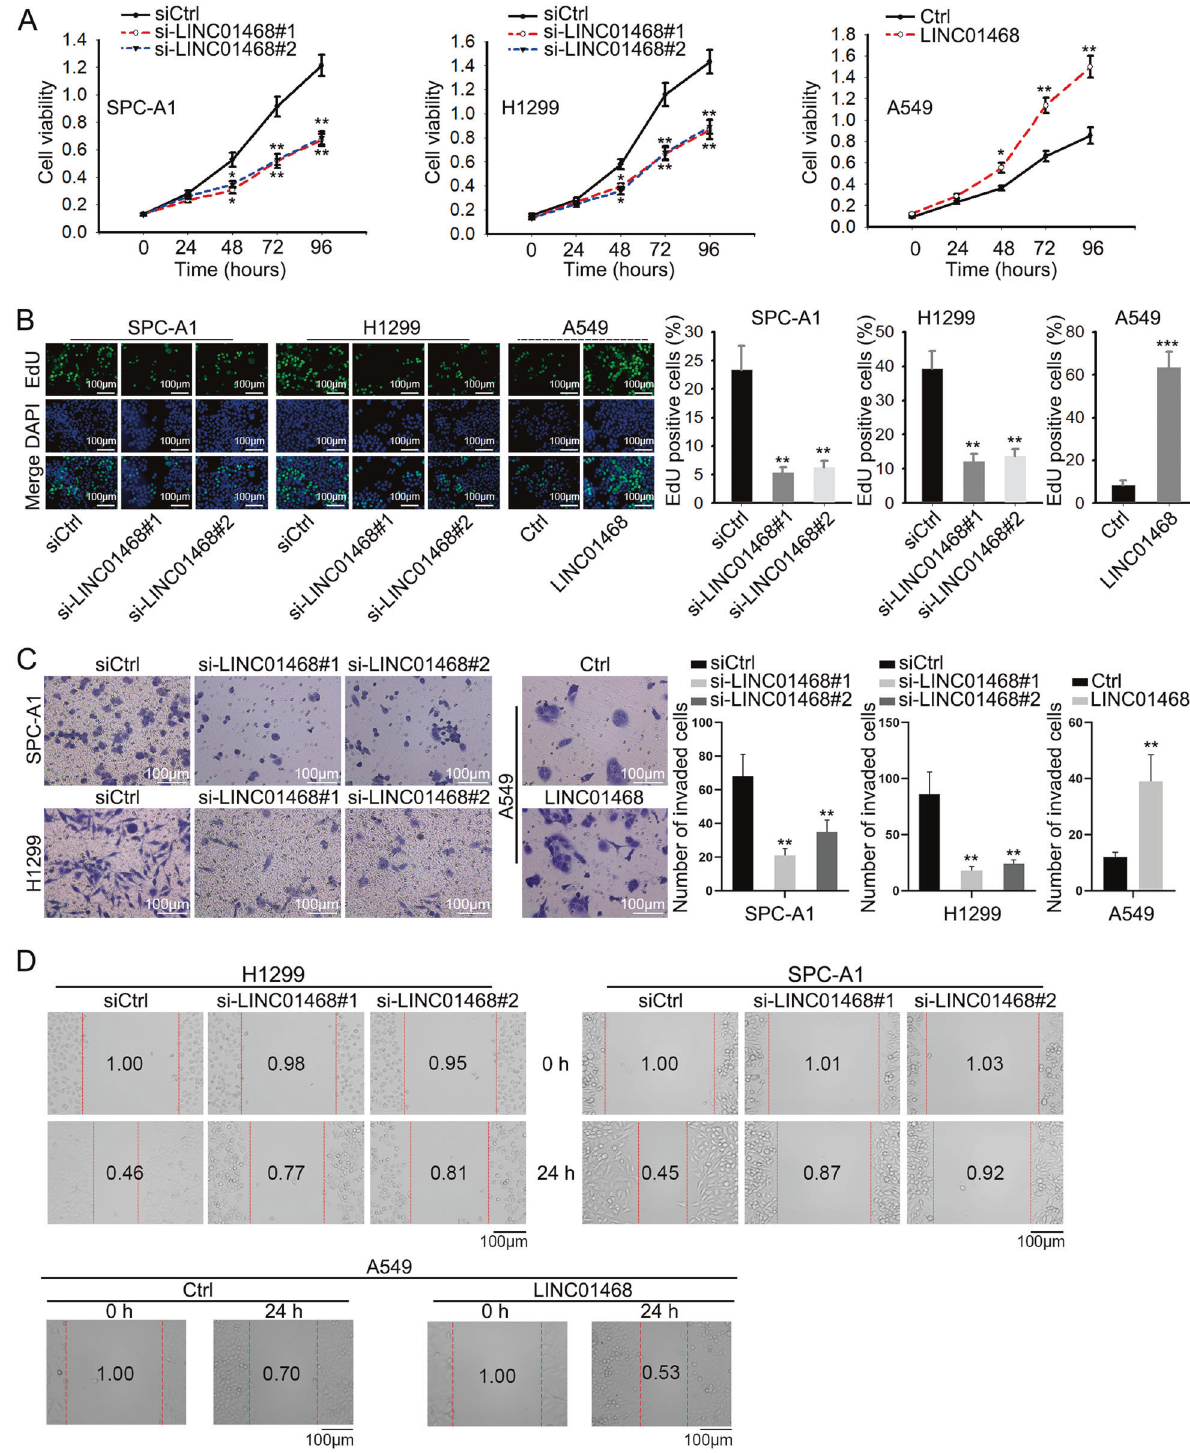
Fig. 2 LINC01468 promotes LUAD cell proliferation, migration, and invasion. A , B CCK-8 and EdU assays were used to analyze the effect of LINC01468 knockdown or overexpression on cell proliferation. C , D Invasive and migratory ability of LUAD cells with LINC01468 de fi ciency or overexpression was detected by transwell invasion and wound healing assays. Results were exhibited as the mean ± SD on the basis of three independent experiments. * p < 0.05, ** p < 0.01 indicated the statistical signi fi cance of experiments